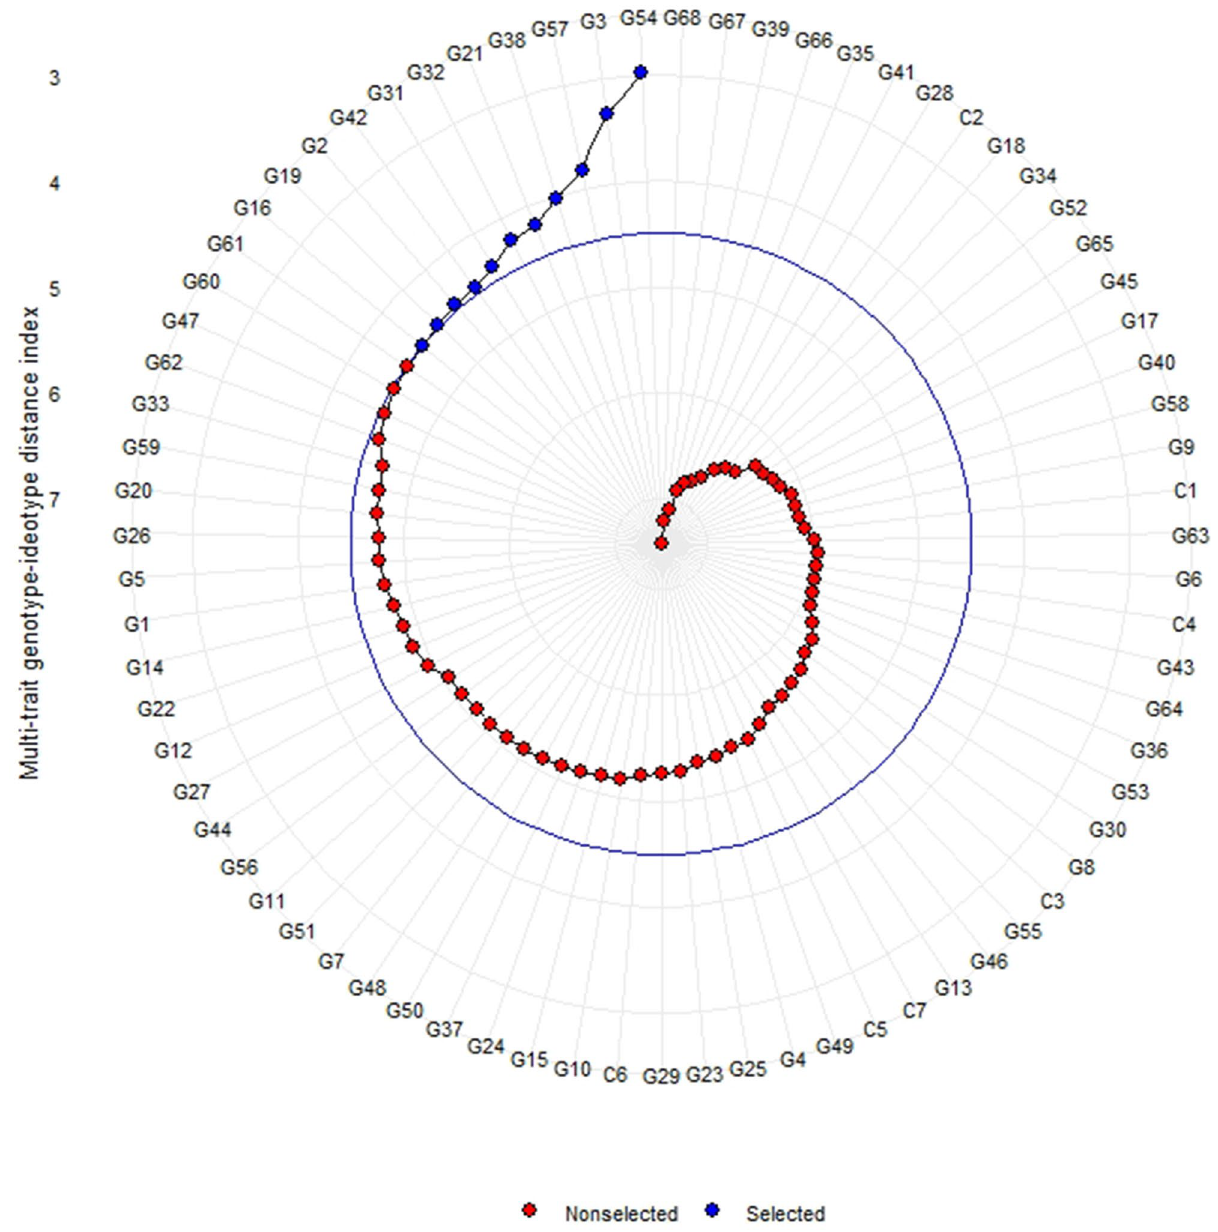
Figure 4. MGIDI index and selection of superior genotypes (Generated using R Package ‘metan’ version 1.15.0 URL https:// github. com/ Tiago Olivo to/